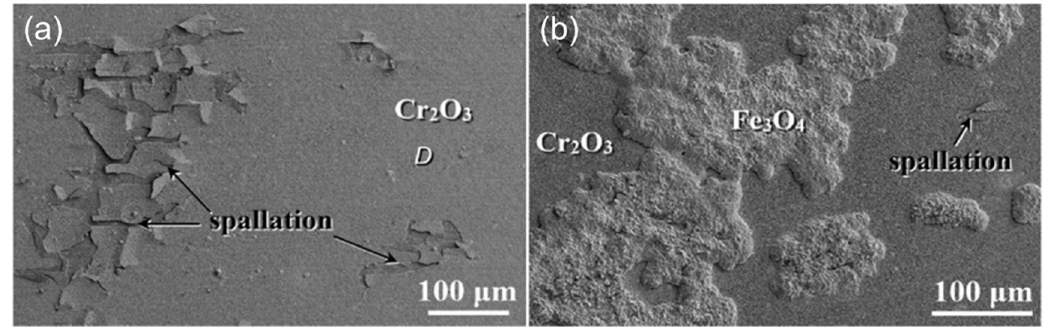
Figure 7. The low magnification SEM image of 347H stainless steel after exposure to S-CO 2 at 650 °C/20 MPa for 500 h ( a ) and 1000 h ( b ) [19]. Reproduced with permission from Elsevier.